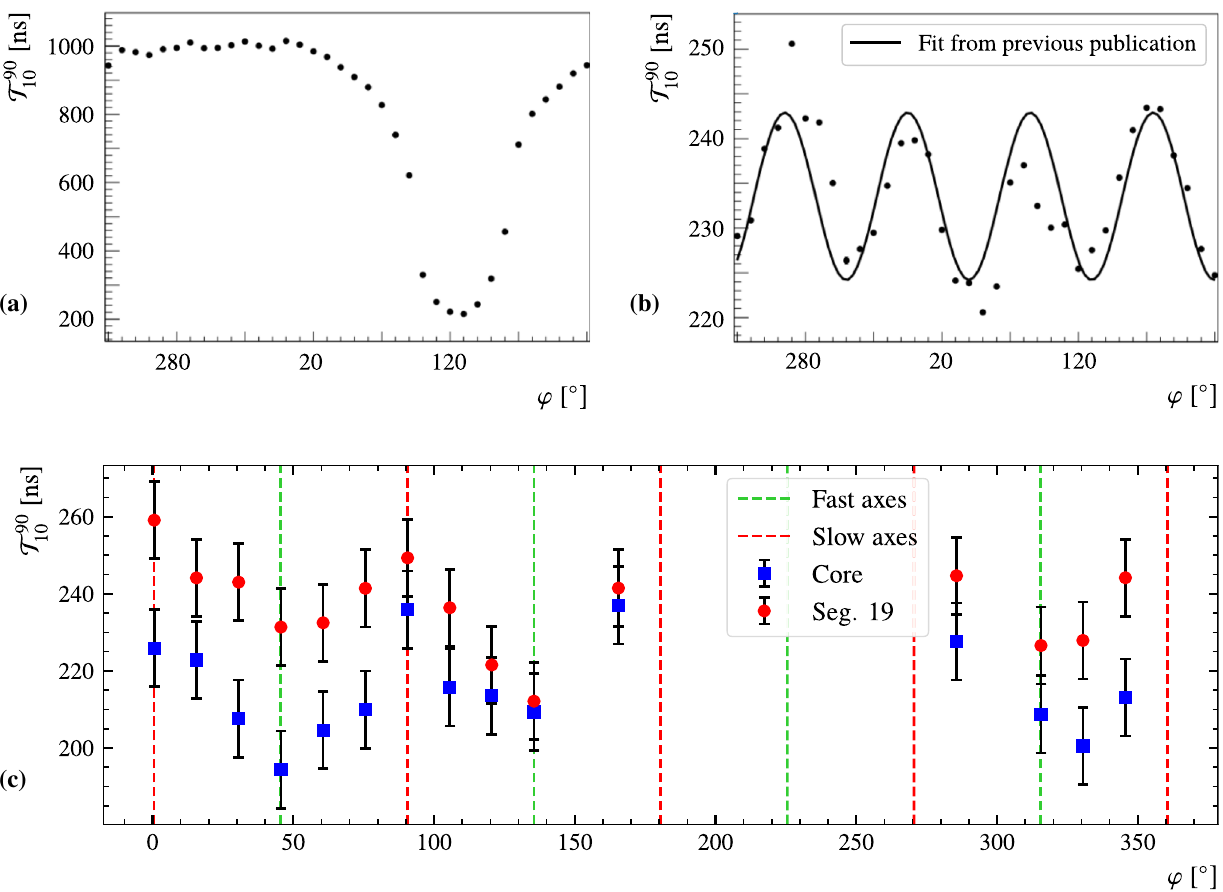
Fig. 24 Averaged rise times T 90 sen for this paper. c Rise times T 90 of events induced by collimated determined from the superpulses 10 10 formed from the gamma events induced by 59.5 keV gammas from the 121.8keV gammas from 152 Eu entering segment 19 from the side for 241 Am source from the rotational side scan ASS after full metalisa- a segment 19 and b the core before full metalisation, adapted from tion. The error bars indicate systematic uncertainties due to the slightly [14,27]. The ϕ -axes were modified to match the coordinate system cho- fluctuating temperature of the detector in GALATEA